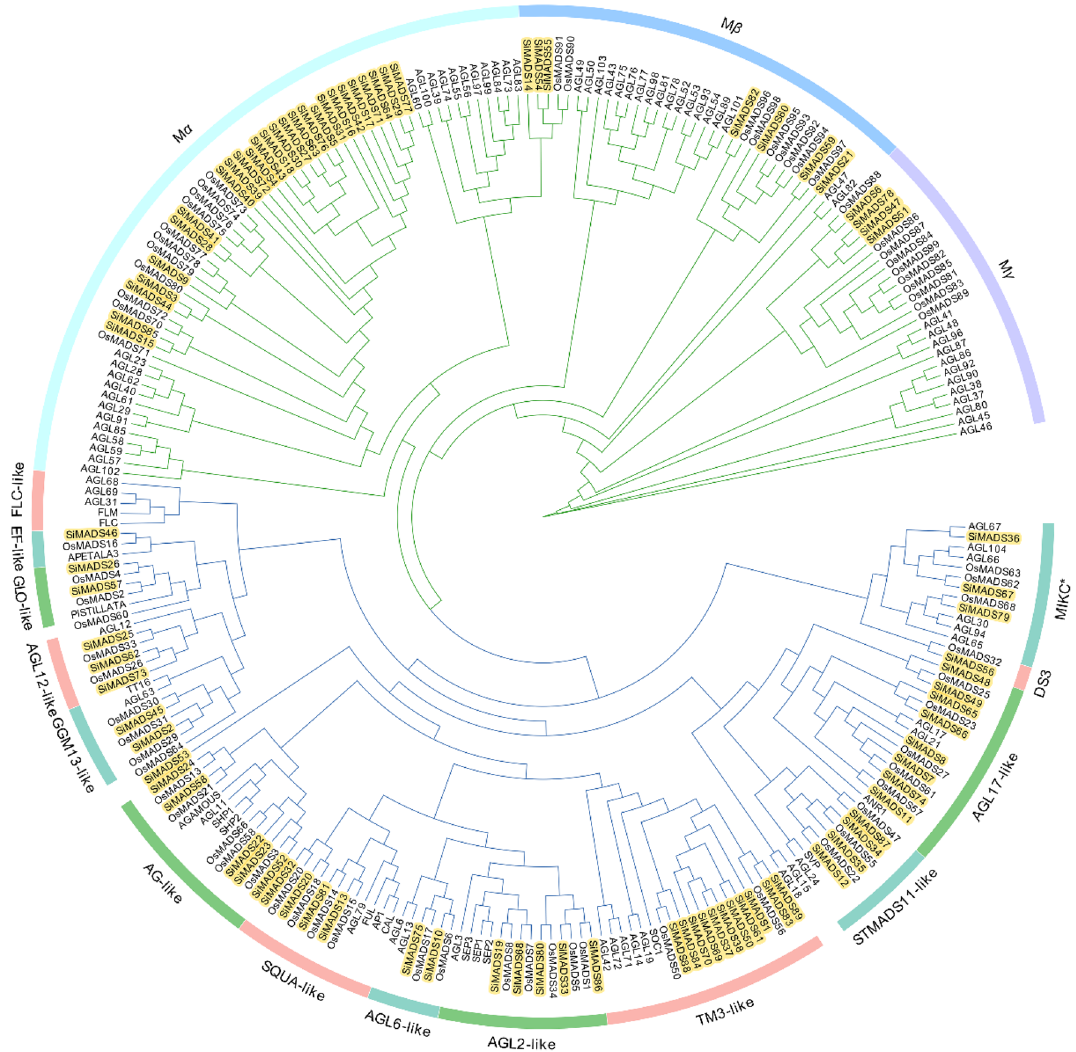
Figure 1. Unrooted phylogenetic tree showing relationships among MADS-box proteins of Setaria italica , rice and Arabidopsis thaliana . The phylogenetic tree was derived using the ML method in MEGA X. The tree shows the 17 phylogenetic subfamilies. MADS-box proteins from rice are marked with the prefix ‘Os’.